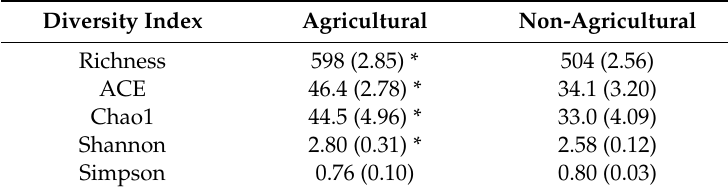
Table 2. Differences in bacterial richness and diversity measures of the 16S rRNA gene libraries between the agricultural and non-agricultural soil samples. Standard deviations (SD) from the means are indicated in parentheses. Values with marked with an asterisk indicate the land use type that was significantly higher for each diversity index.